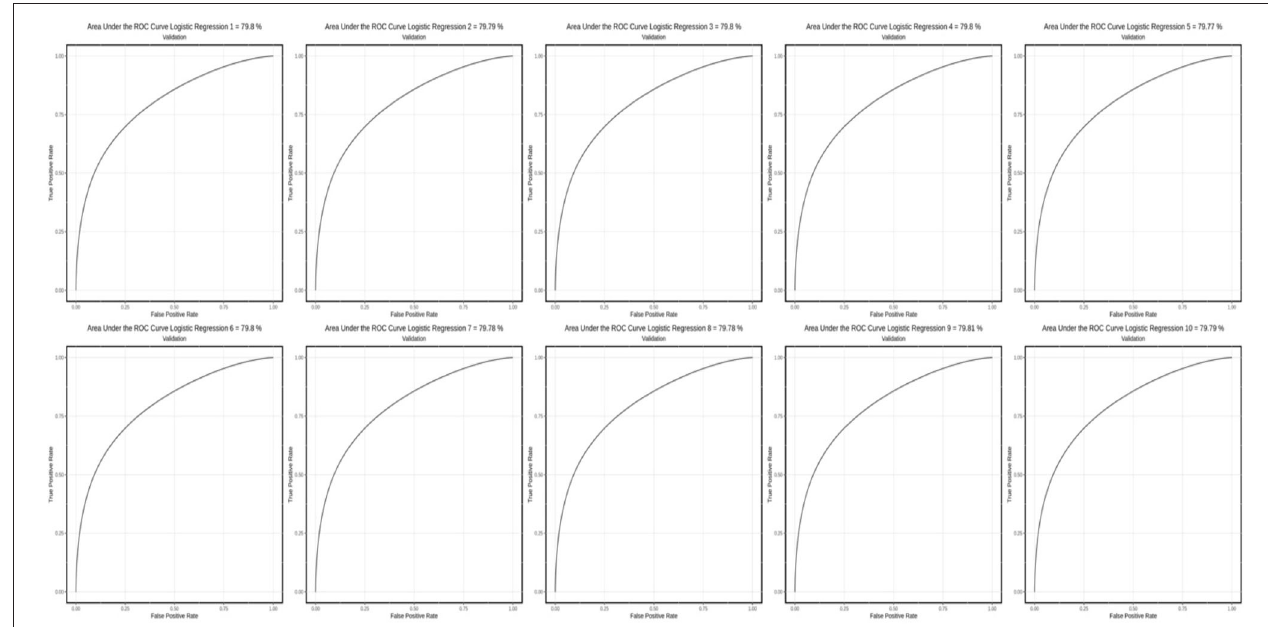
FIGURE 3 | AUC performance on the classification method with the 10-fold CV using the Logistic Regression